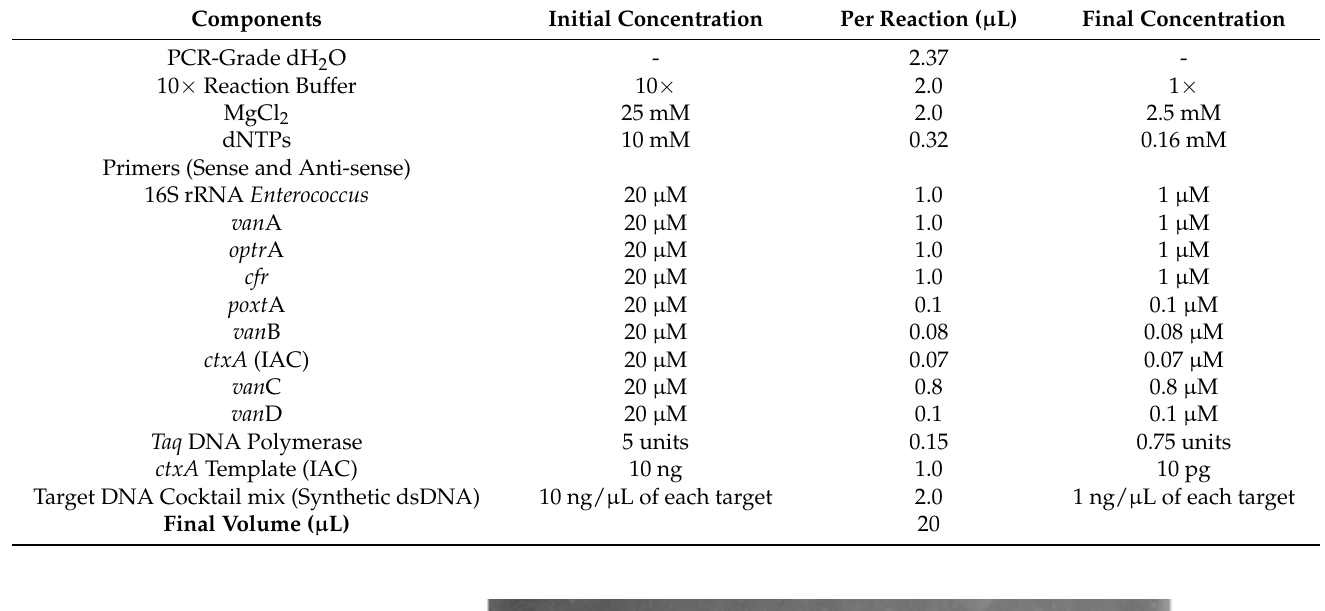
Table 5. Final optimized parameters of the nanoplex PCR assay for the detection of vancomycin- and linezolid-resistant genes in Enterococcus .